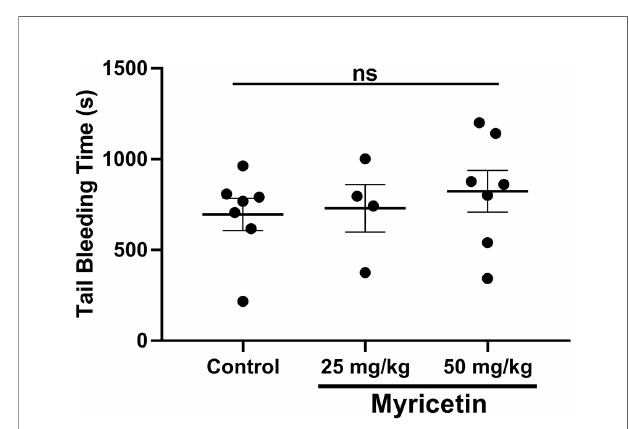
FIGURE 5 | Myricetin does not affect hemostasis in vivo . Myricetin at 25 mg/ kg or 50 mg/kg as well as vehicle control were administered to healthy mice by oral gavage for three consecutive days. Tail bleeding was measured after tail tip amputation. Data expressed as mean ± SEM as well as individual points. There was no statistical difference between groups.